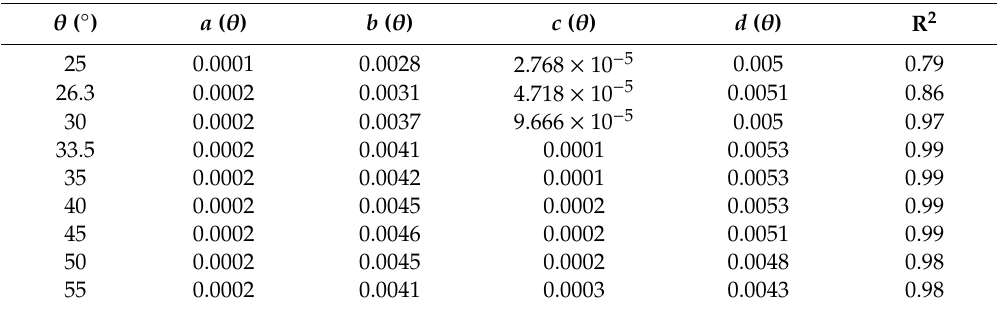
Table 4. Empirical coe ffi cients at di ff erent incidence angles in VH polarization ( Hrms ∈ (0.5, 4)